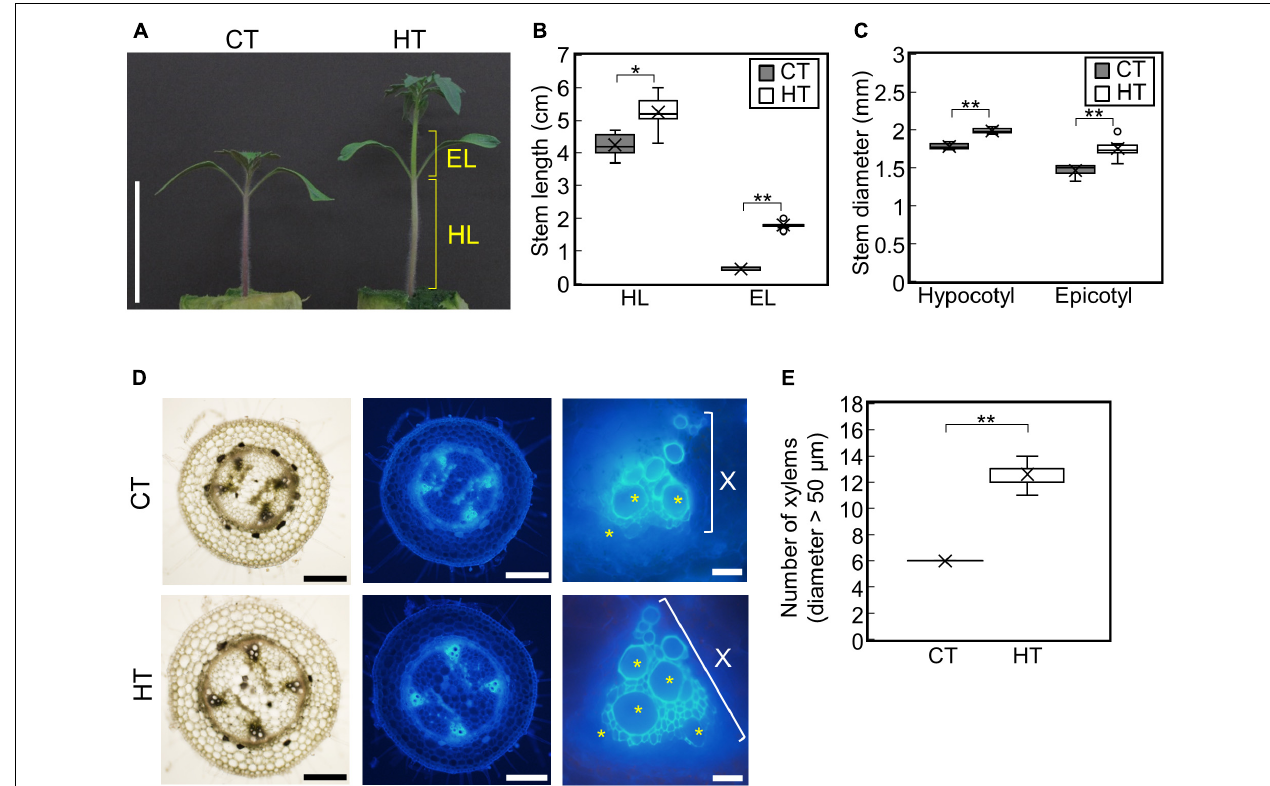
FIGURE 1 | Effect of temperature on growth of tomato seedlings. Young tomato seedlings were grown for 7 days under 25 ◦ C/20 ◦ C (control temperature) and 30 ◦ C/25 ◦ C (high temperature). (A) , Growth of seedlings. Tomato seedlings were photographed at 7 days. Scale bar = 5 cm. (B) , Hypocotyl and epicotyl length. (C) , Hypocotyl and epicotyl diameter. Data are shown as boxplots ( n = 7). (D) , Cross sections of hypocotyls. Asterisks indicate xylems (diameter > 50 µ m). Scale bars = 500 µ m (left and middle panels) and 50 µ m (right panels). (E) , Number of xylems (diameter > 50 µ m) in the cross section. Data are shown as boxplots ( n = 5). Cross marks in boxplot indicate the mean values. * P < 0.01; ** P < 0.001 (Student’s t test). CT, control temperature; HT, high temperature; HL, hypocotyl length; EL, epicotyl length; X, xylem